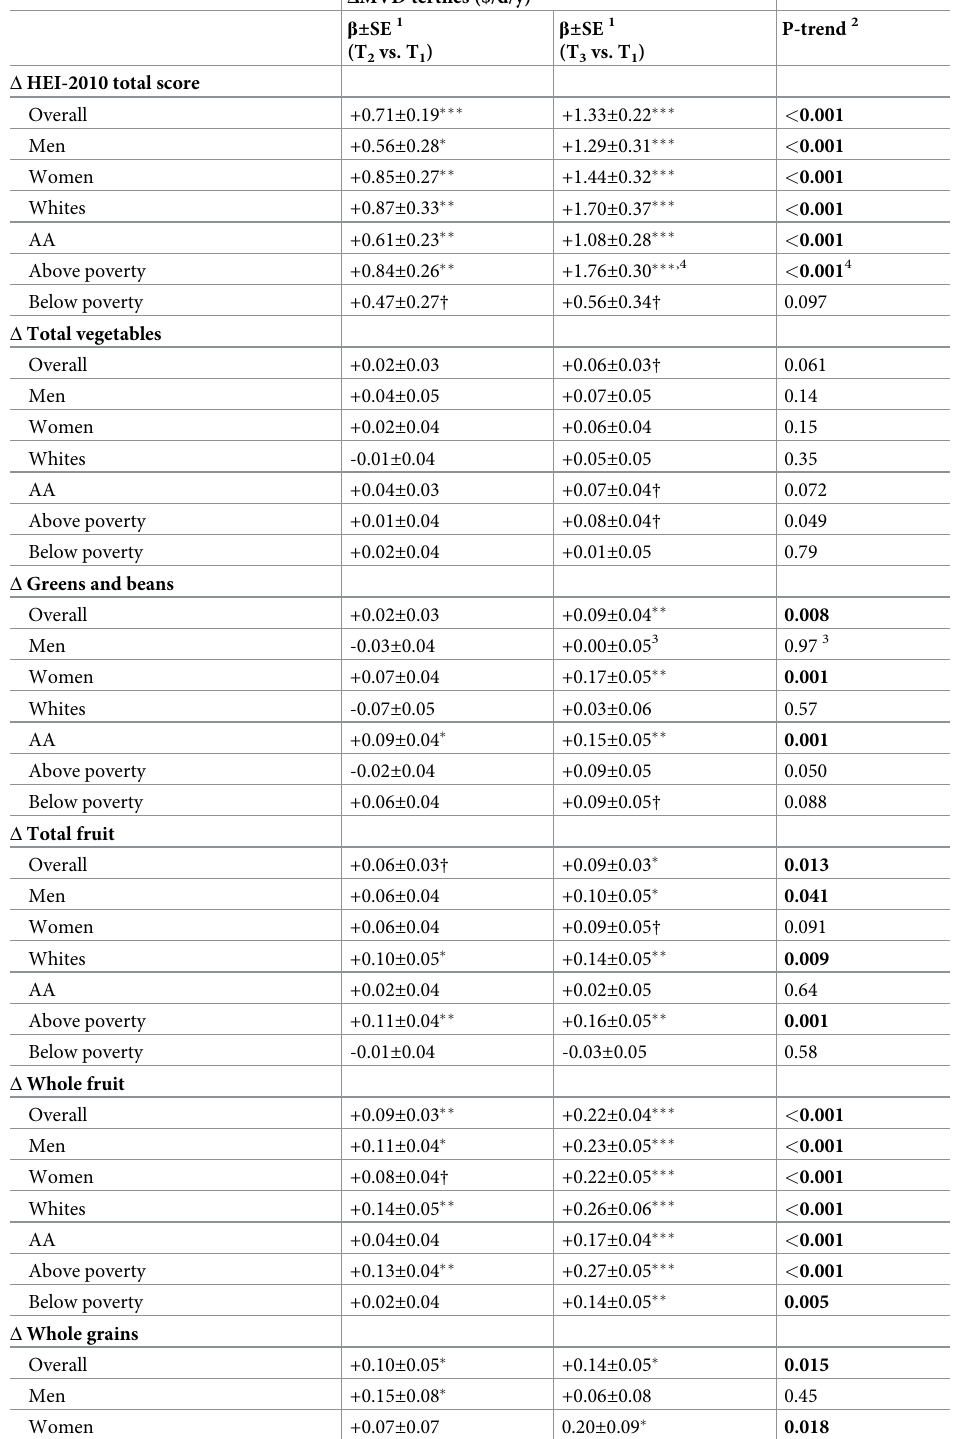
Table 2. Annual rate of change in MVD tertiles as predictors of annual rate of change in the HEI-2010 (total score and components), stratifying by sex, race and poverty status: Multiple ordinary least square regression models, HANDLS 2004 − 2013 5